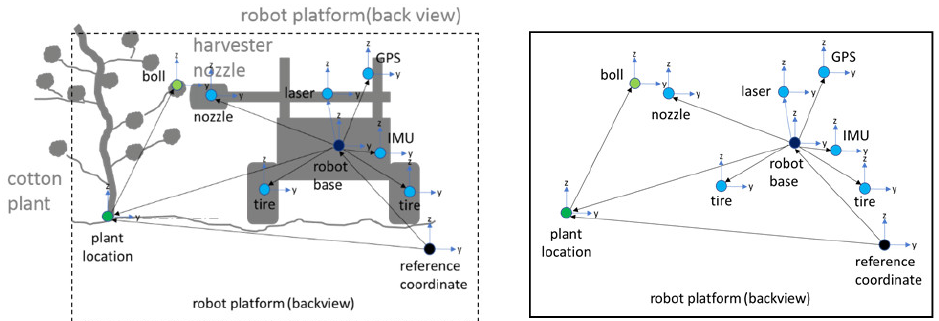
Figure 11. Relative positions of harvester nozzle versus cotton bolls with respect to robot base and plant location under a common reference coordinate.